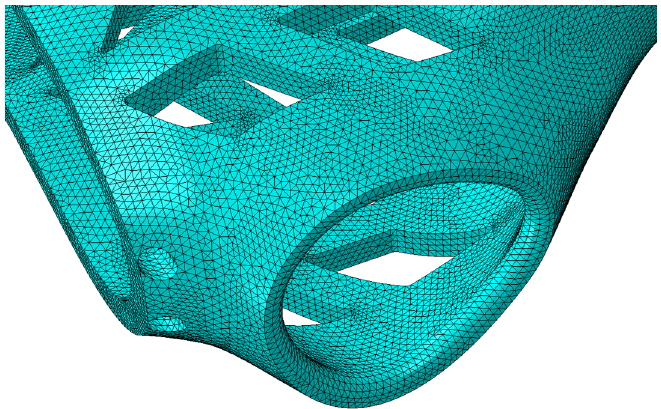
Figure 6. Boundary conditions and method of loading the sample in the shape of: the middle part of the orthosis: ( a ) full (series F), ( b ) with openwork (series O), ( c ) whole orthosis (WHO series). View of a fragment of the finite element mesh of the orthosis model that accurately reflects the samples are presented in Table 3.